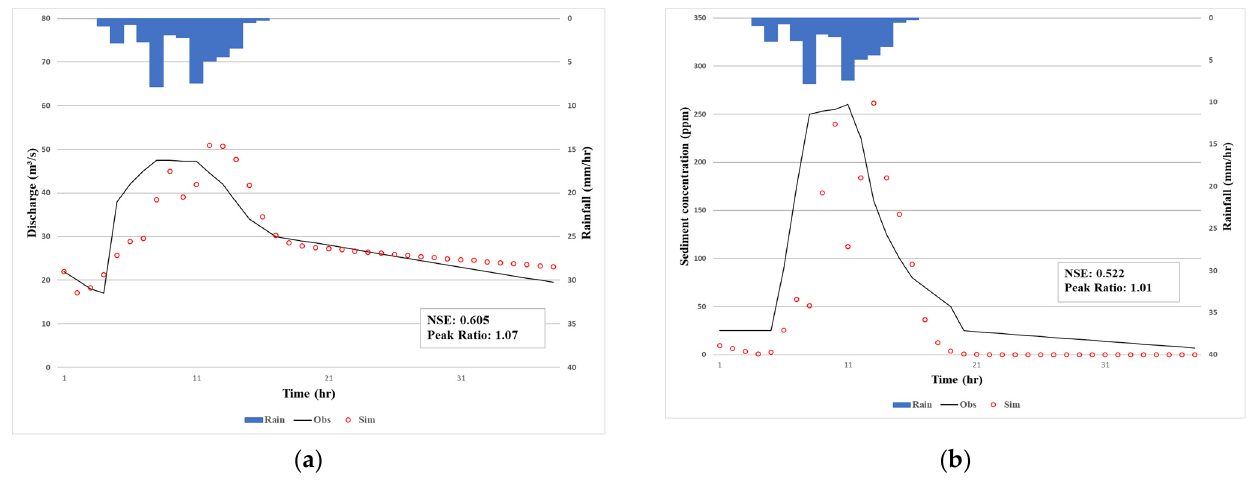
Figure 11. Comparison of the simulated hydrological time series by the calibrated model to observations; ( a ) hydrograph, ( b ) sedigraph. Table 7. The optimal parameters used in R-SSEM and MR-SSEM.